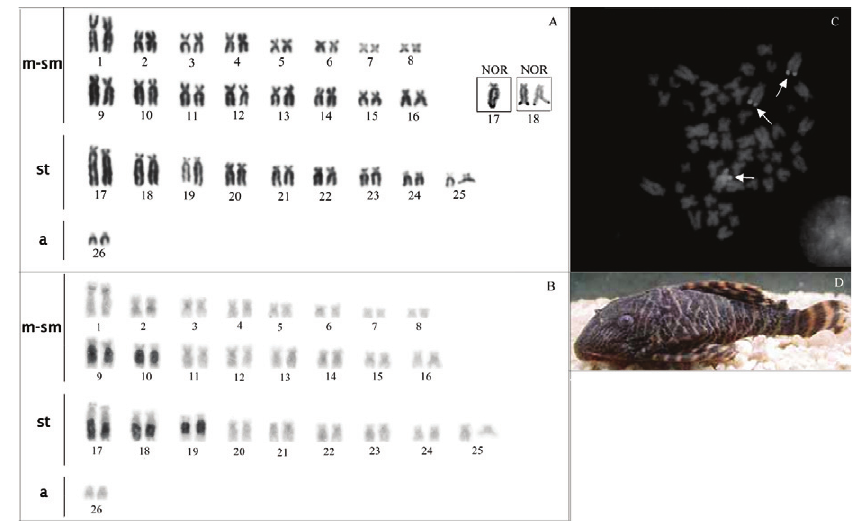
Fig. 3. Karyotype of a Peckoltia sp. 2, sequentially Giemsa-stained ( A ) and C-banded ( B ) chromosomes. The CMA -stained metaphase of the same specimen ( C ) revealed CMA 3 NOR-bearing chromosome pair. The specimen was obtained from river Jari ( D